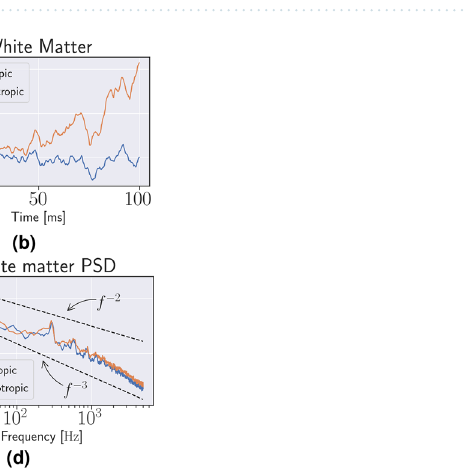
Figure 4. Three-dimensional simulations Two visualisations of the extracellular potential in the head and on the brain surface after 100 ms. The colormap is scaled to highlight the waves, and does not cover the range of the extracellular potential. ( a ) The extracellular potential throughout the brain and the surrounding tissue in a corner of the head. The surrounding tissue is shown in colors similar to Fig. 1b, while the magnitude of the extracelular potential shown is shown in the grey matter and white matter. The horizontal slice also shown the magnitude of the extracelular potential in the cerebrospinal fluid, skull and scalp. ( b ) The extracelular potential on the surface of the brain.